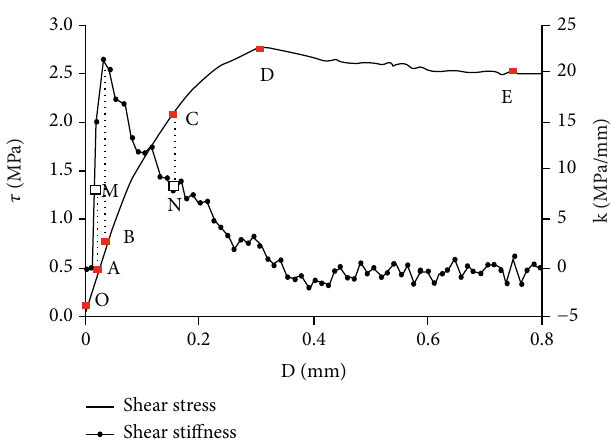
Figure 9: Shear stress-shear sti ff ness-shear deformation curve.